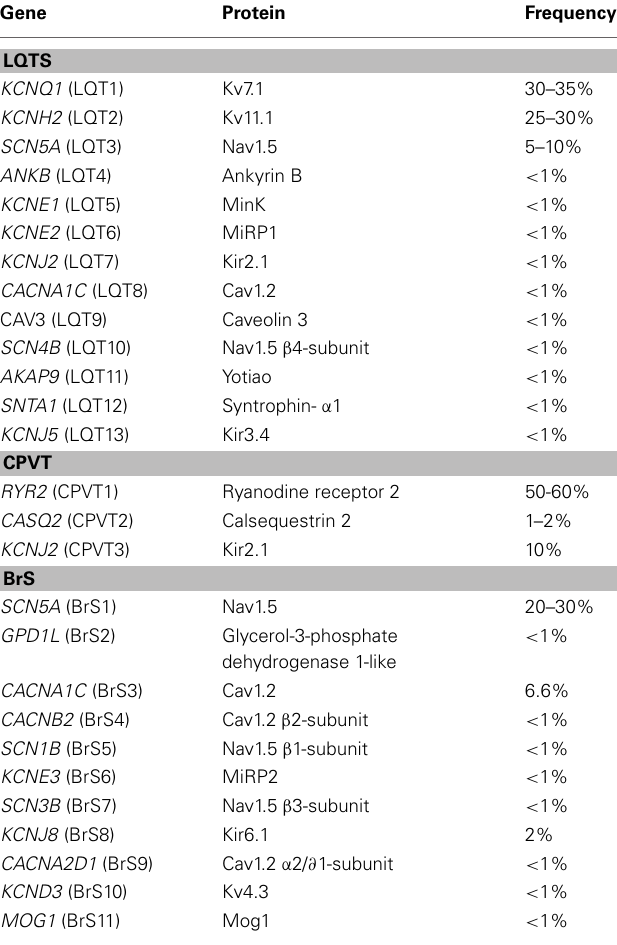
Table 1 | Genetic basis of principal ion channelopathies [adapted from Table 1, Giudicessi and Ackerman